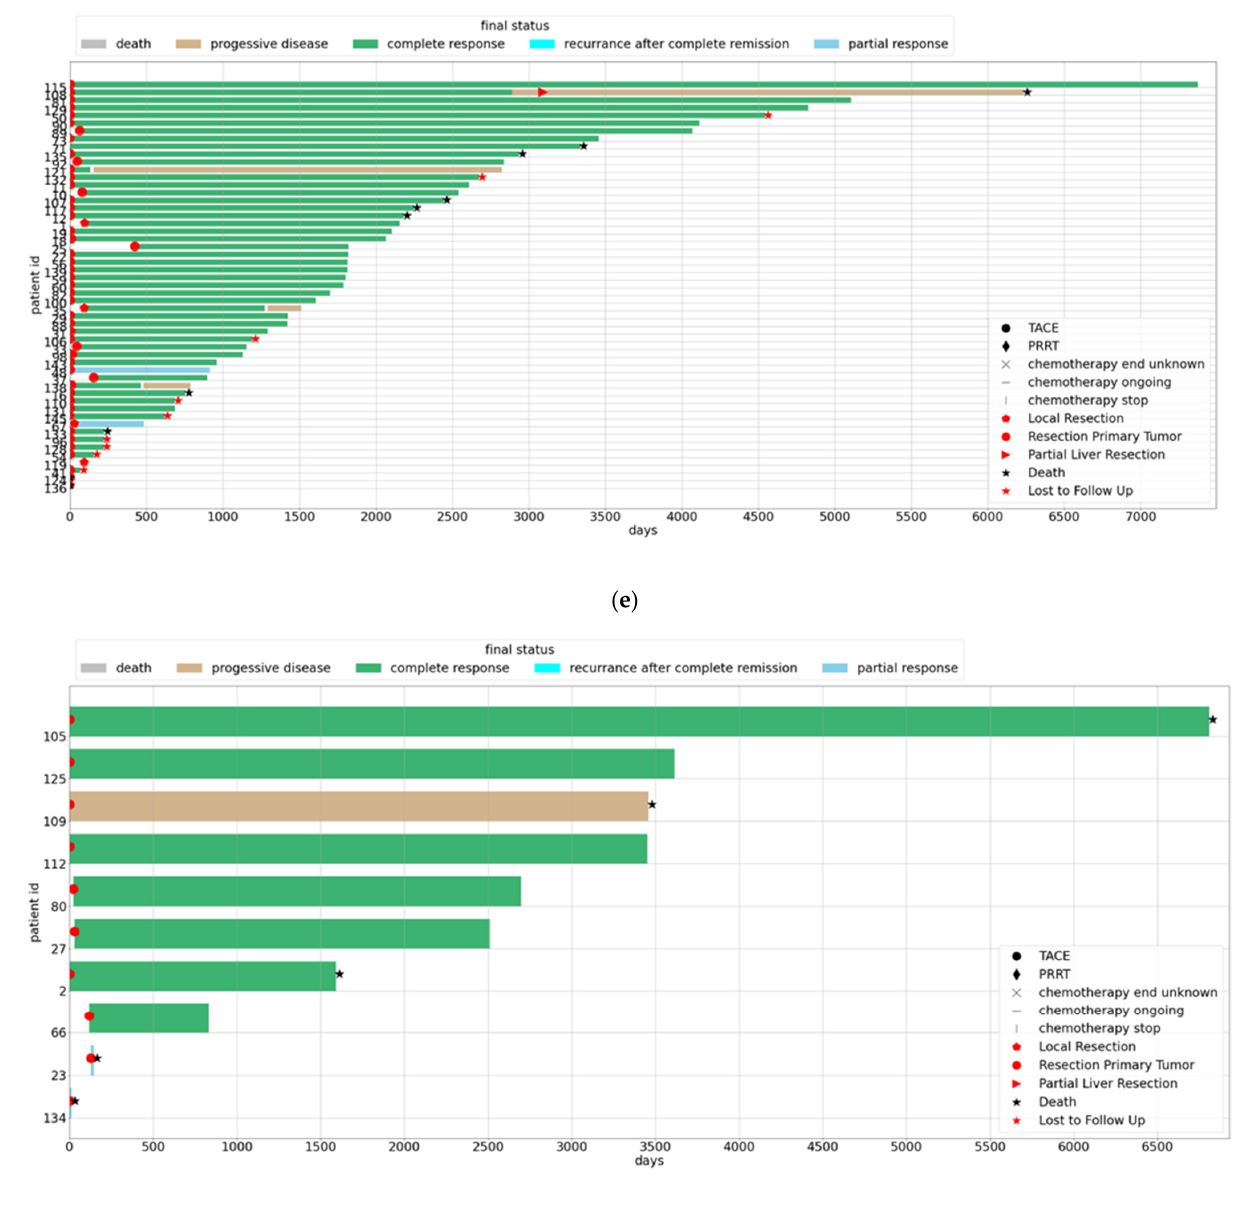
Figure 3. ( a ): Swimmer plot, group 1: patients ( n = 32) treated with SSA alone; colors denote the final status (details in the figure legend), symbols denote different treatments . ( b ): Swimmer plot, group 2: patients ( n = 26) treated with SSA parallel with TACE and/or PRRT; colors denote the final status , symbols denote different treatments . ( c ): Swimmer plot, group 3: patients ( n = 8) treated with SSA followed by PRRT; colors denote the final status , symbols denote different treatments . ( d ): Swim- mer plot, group 4: patients ( n = 8) treated with chemotherapy; colors denote the final status , symbols denote different treatments . ( e ): Swimmer plot, group 5: patients ( n = 53) not metastasized at diag- nosis, local resection; colors denote the final status , symbols denote different treatments . ( f ): Swim- mer plot, group 6: patients ( n = 10) metastasized at diagnosis, surgery only; colors denote the final status , symbols denote different treatments .